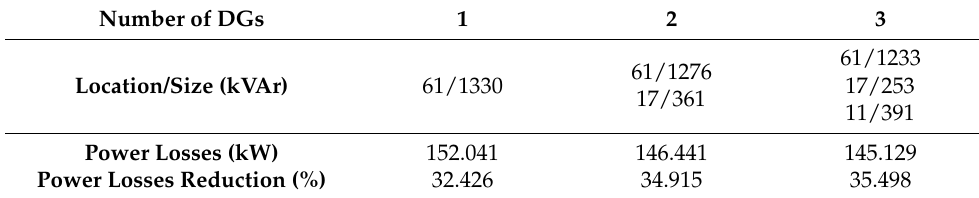
Table 2. Configuration of Q-type DGs installed in the IEEE-69